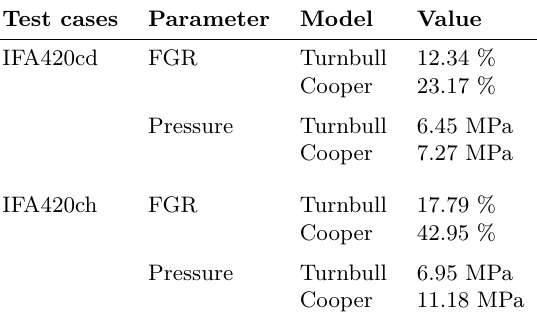
Table 2. Model verification using IFA 429 case.